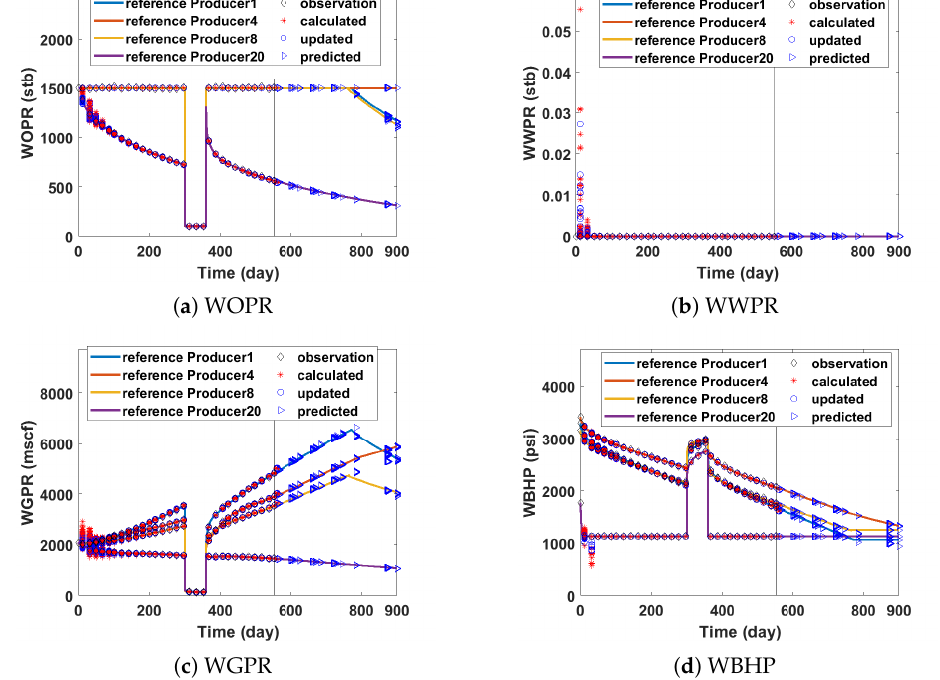
Figure 10. The oil production rates, the water production rates, the gas production rates and the bottom-hole pressure of the selected production wells with unknown